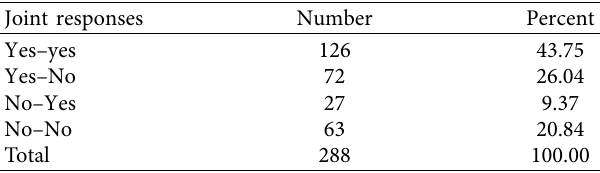
Table 5: Joint responses of households’ willingness to pay.